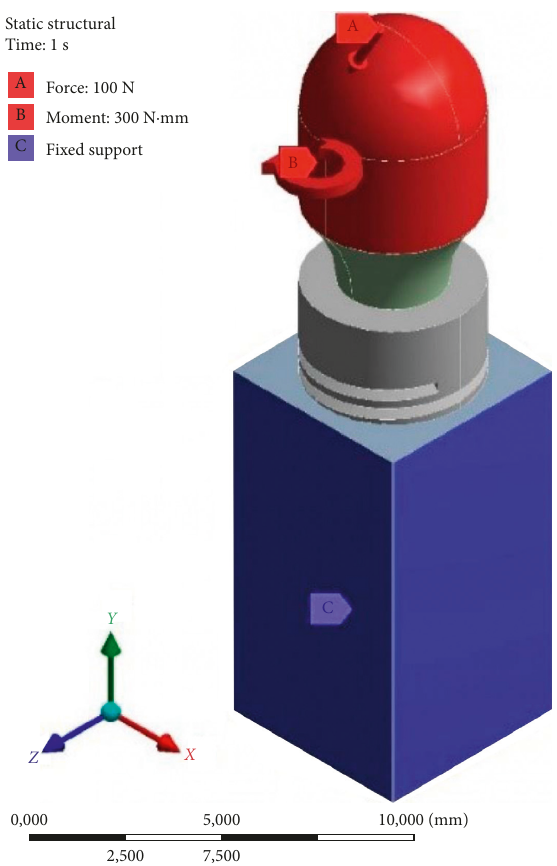
Figure 2: Isometric view of the FEA initial